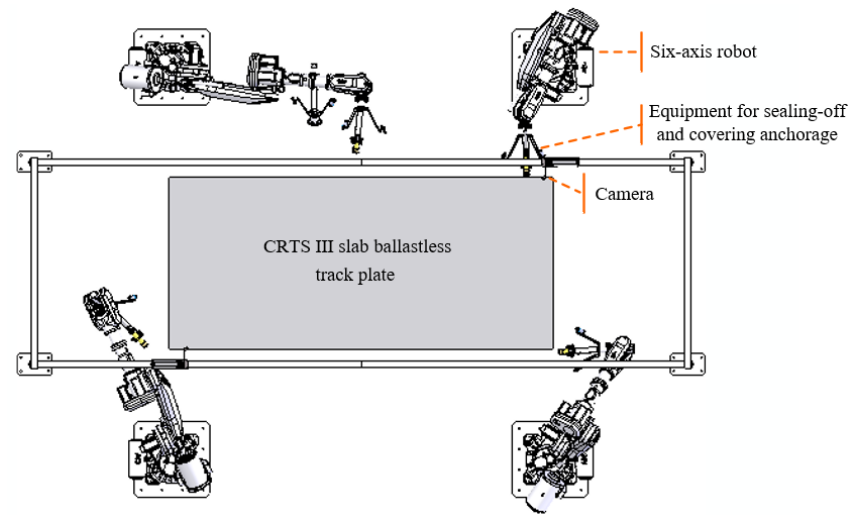
Figure 2. Schematic diagram of the anchor sealing platform.